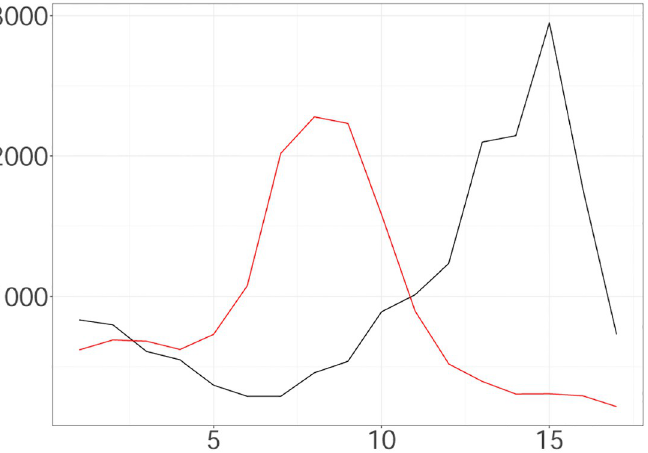
Fig 2. Weekly Observed Data (Scenario A (black line); Scenario B (red line)) plotted against